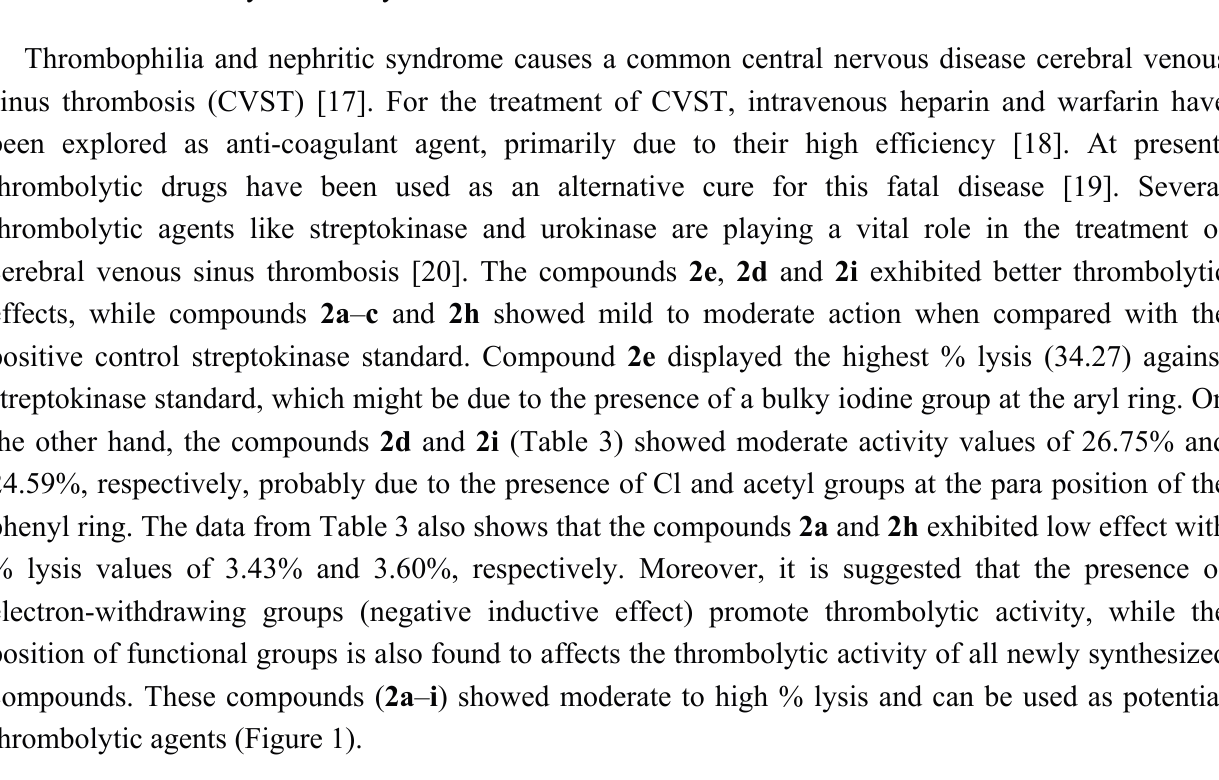
Table 3. Anti-thrombolytic activity data of 5-aryl-2-bromo-3-hexylthiophene based compounds ( 2a – i